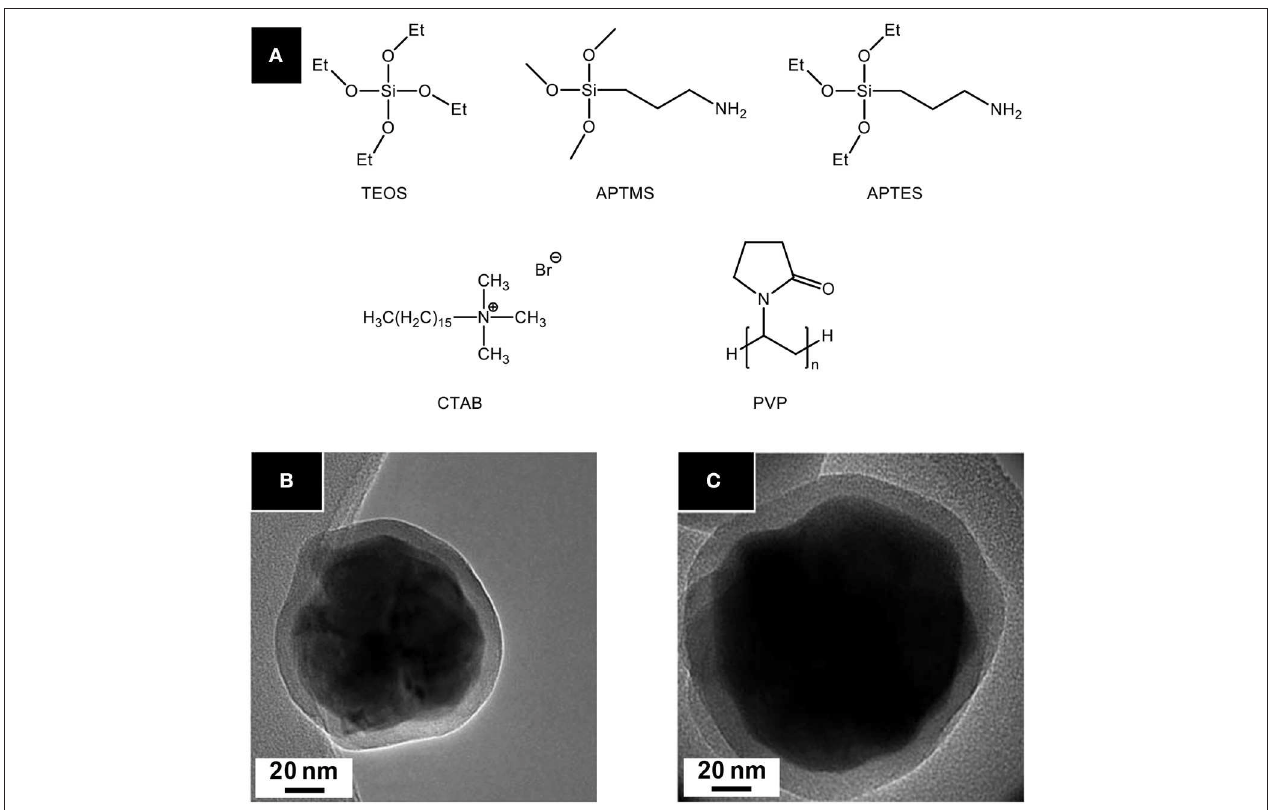
FIGURE 10 | (A) Precursors and additives commonly used for nanoparticles silica coating. Tetraethylorthosilicate (TEOS) is used as silica precursor; 3-aminopropyltrimethoxysilane (APTMS), and 3-aminopropyltriethoxysilane (APTES) are rather employed for silica functionalization. TEM micrographs of Gd 2 O 2 S:Eu@SiO 2 -APTMS (B) and Gd 2 O 2 S:Eu@mSiO 2 (C) nanoparticles from Osseni et al. (mSiO 2 stands for mesoporous silica). Adapted from Osseni et al. (2011) with permission of The Royal Society of